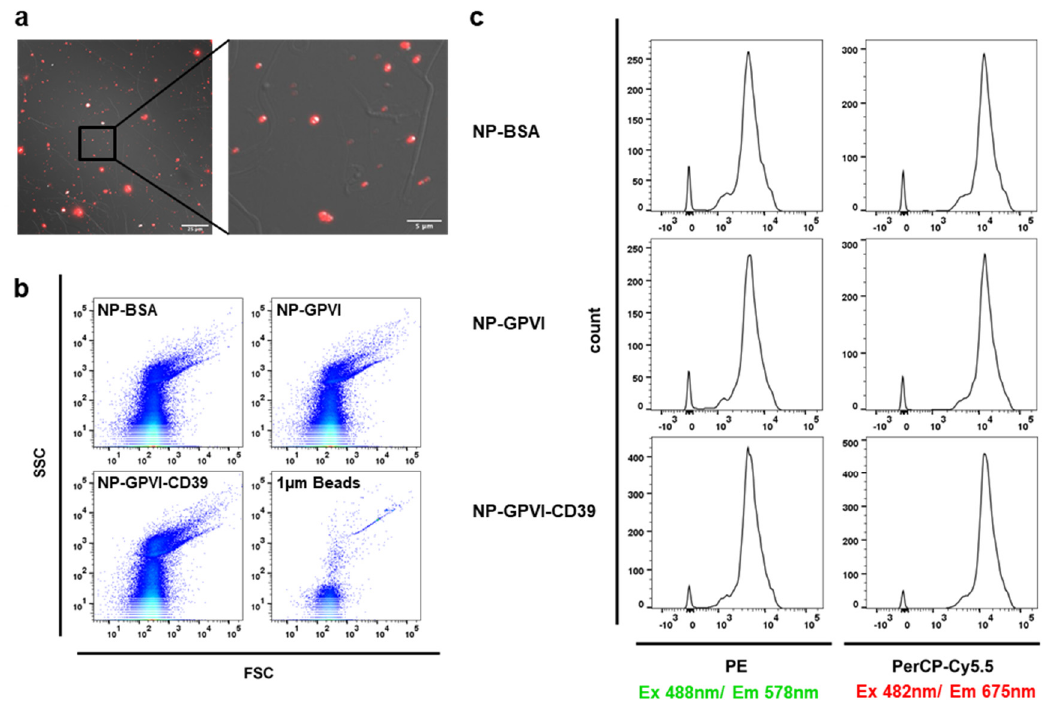
Figure 4. Fluorescence properties of the nanoparticles ( a ) Merged differential interference contrast (DIC) and fluorescence microscopy image of the nanoparticles (nile red) after adhesion to collagen- coated cover slips. 100× magnification, scale bar = 25 μ m. ( b ) Flow cytometric detection of the nanoparticles, demonstrating the particle distribution of all three nanoparticle samples, as well as a sample containing 1 μ m beads, in both FSC and SSC detection channels. ( c ) Histograms displaying the fluorescence intensities of the nanoparticle samples in flow cytometric analysis in both phycoerythrin (PE) and peridinin chlorophyll protein (PerCP) fluorochrome detection channels after 488 nm excitation.